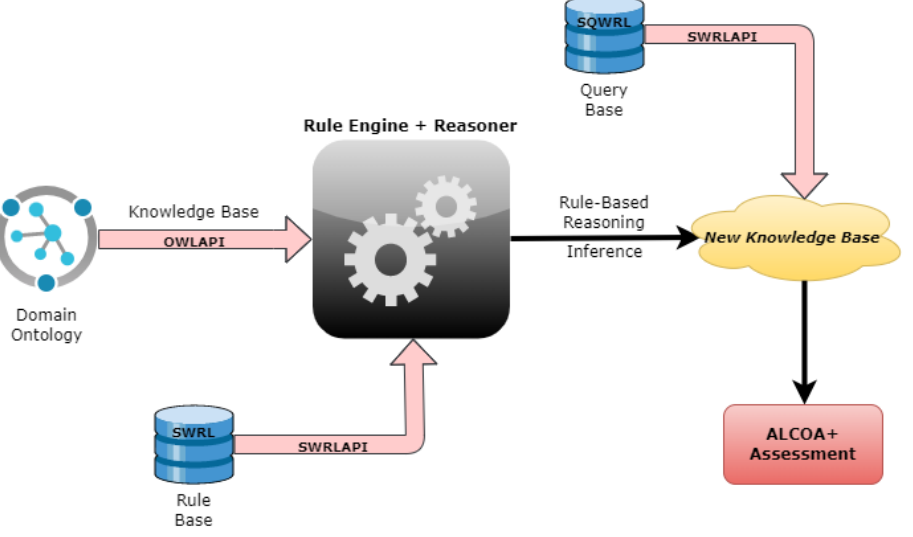
Figure 4. DIOnt software methodology architecture.